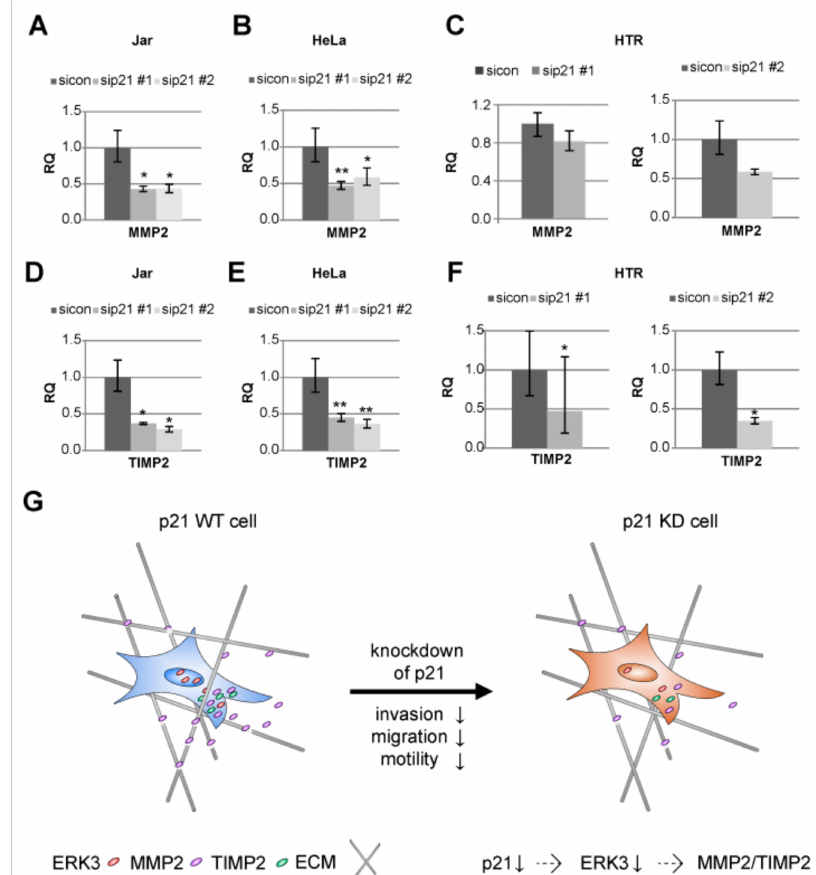
Figure 6. Matrix metalloproteinase 2 (MMP2) and tissue inhibitor of metalloproteinase 2 (TIMP2) are reduced upon p21-silencing. The gene levels of MMP2 ( A – C ) and TIMP2 ( D – F ) were evaluated from Jar (A and D), HeLa (B and E), and HTR (C and F) cell lines. The data are based on three independent experiments and presented as RQ with minimum and maximum range and statistically analyzed. RQ: relative quantification of the gene expression. * p < 0.05, ** p < 0.01. ( G ) Schematic illustration of the proposed working